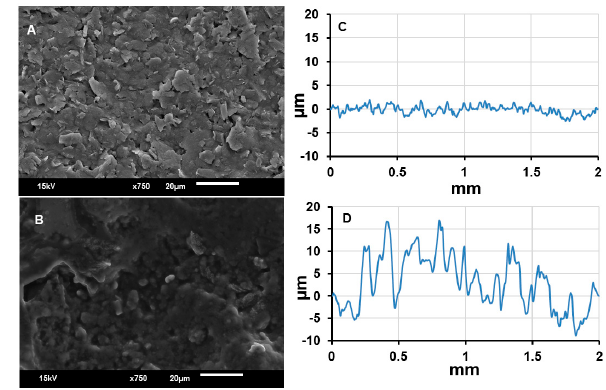
Figure 4. ( A , B ) scanning electron microscopy (SEM) images of SPCE and PEDOT:PSS/20%IL/SPCE sensor and ( C , D ) their corresponding surface roughness obtained from profilometry.